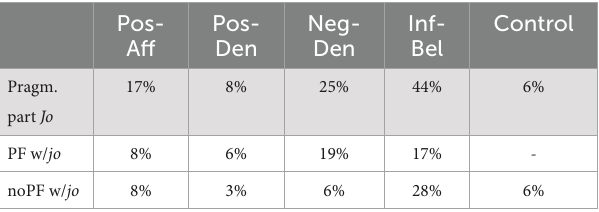
TABLE 5 Productions of the Norwegian sentence-internal pragmatic particle jo by condition ( N = 36).